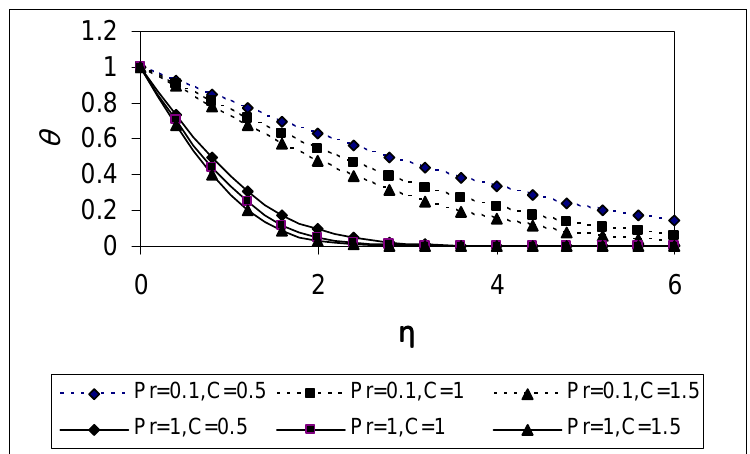
Fig. 3. Effect of the parameters C and Pr on the profile of q ( K =1, B =0.1).